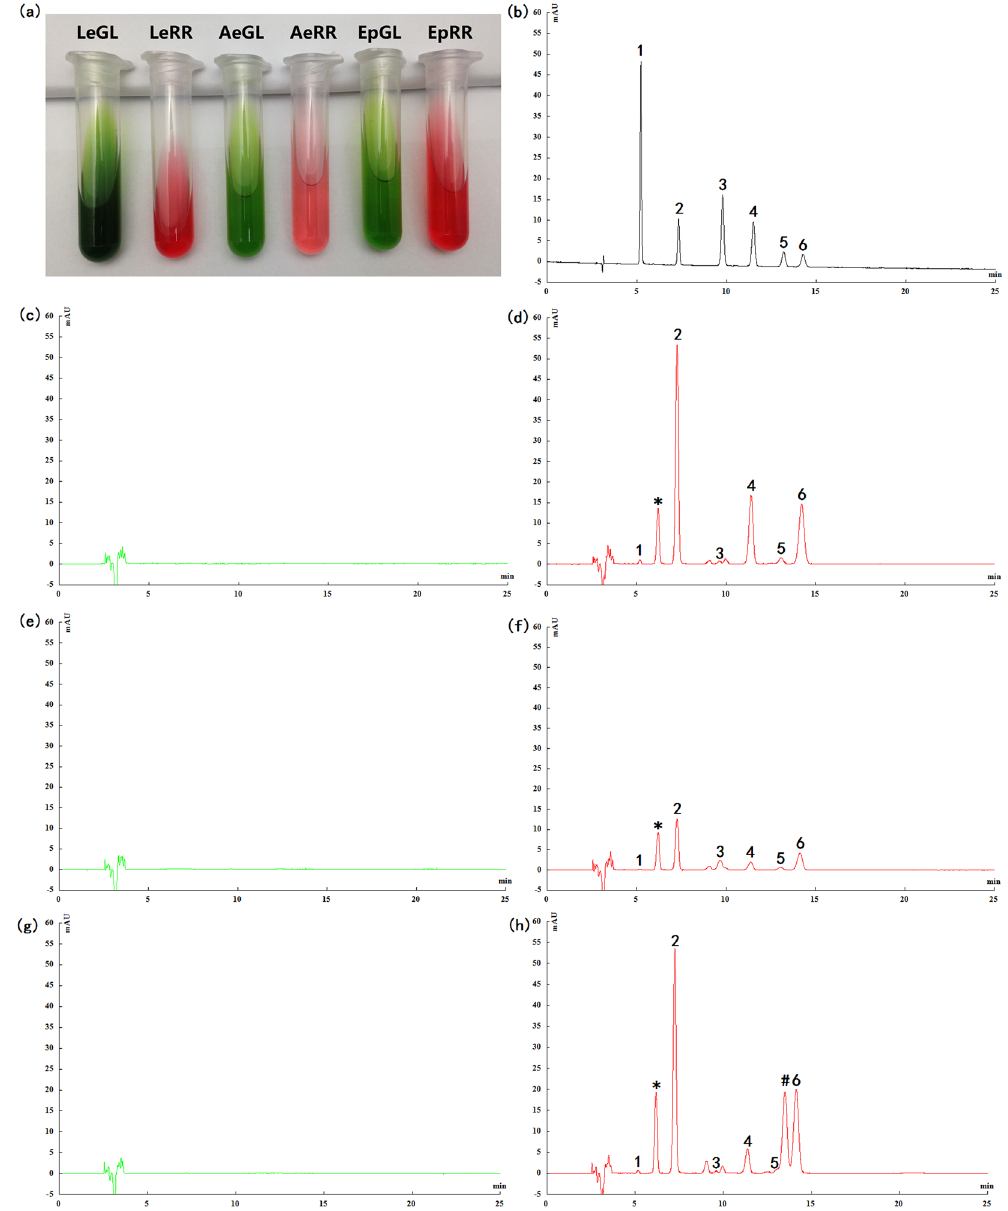
Figure 1. Detection of shikonin and its derivatives in the GL and RR lines of the three Lithospermeae plants (i.e., Lithospermum erythrorhizon , Arnebia euchroma and Echium plantagineum ) by HPLC. ( a ) The ethanol extracts from the above three Lithospermeae plants, ( b ) standards, ( c ) LeGL, ( d ) LeRR, ( e ) AeGL, ( f ) AeRR, ( g ) EpGL, ( h ) EpRR; 1. Shikonin, 2. Acetylshikonin, 3. Deoxyshikonin, 4. Isobutylshikonin; 5. β , β ’- Dimethylacrylshikonin, 6. α -Methyl-n-butyrylshikonin/Isovalerylshikonin (isomerized products can not be separated in this study). * β -Hydroxyisovalerylshikonin (inferential). # Unknown